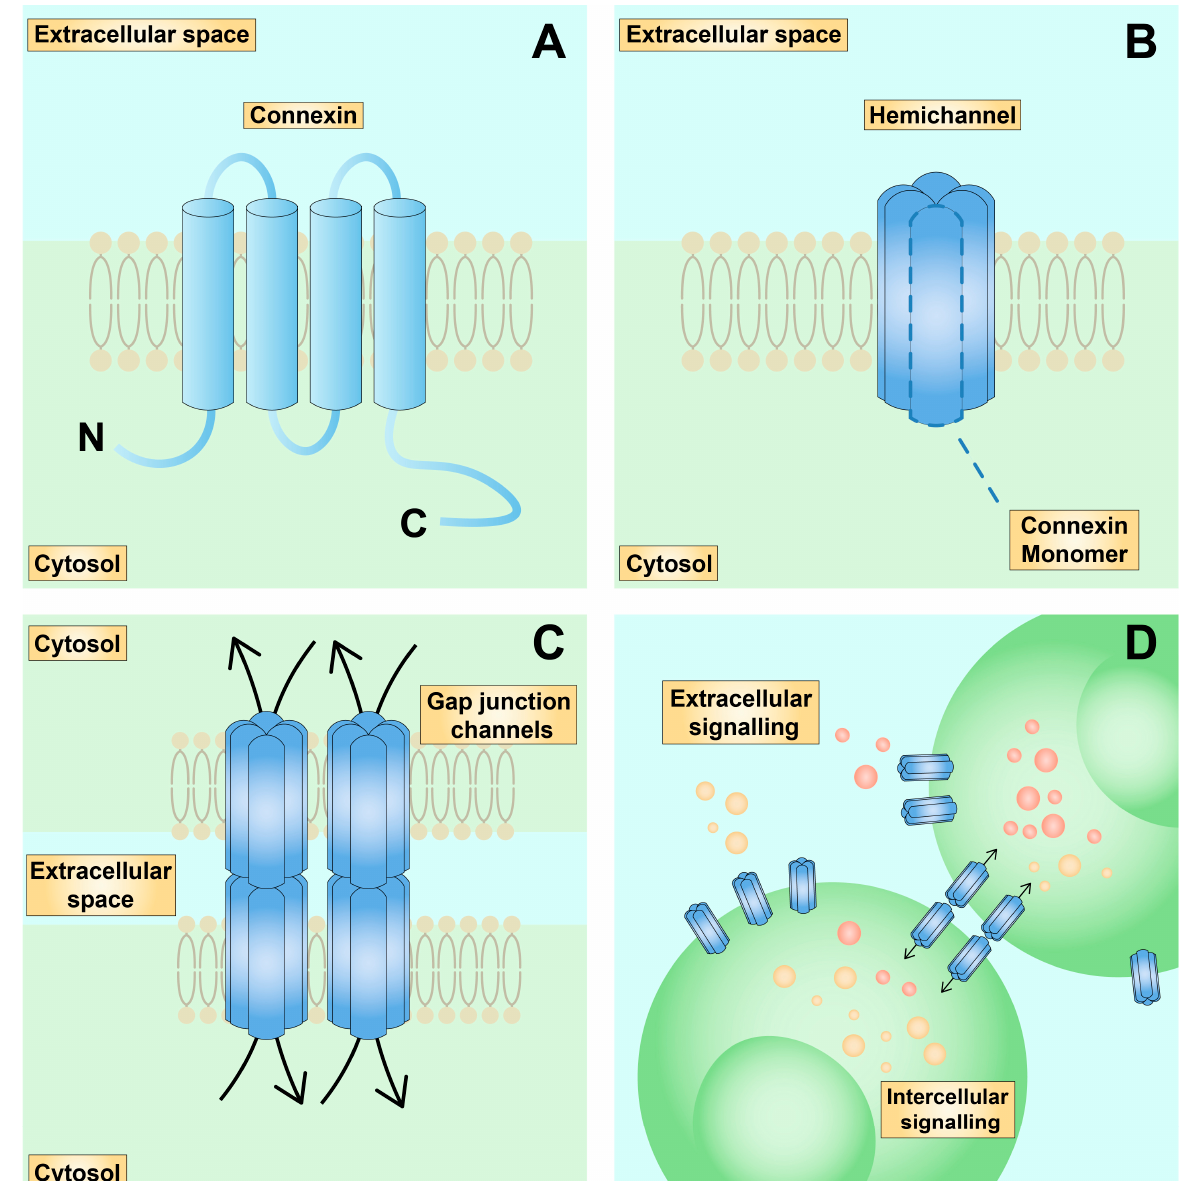
Figure 1. Structure of channels formed by connexins. ( A ): Schematic representation of a connexin composed of four transmembrane domains, two extracellular loops, one cytoplasmic loop, and carboxyl- and amino-termini. ( B ): Schematic representation of a hemichannel which consists of six subunits. ( C ): Schematic representation of gap junctions formed by two hemichannels. ( D ): Schematic representation of inter- and extracellular communication through gap junctions and hemichannels, respectively.